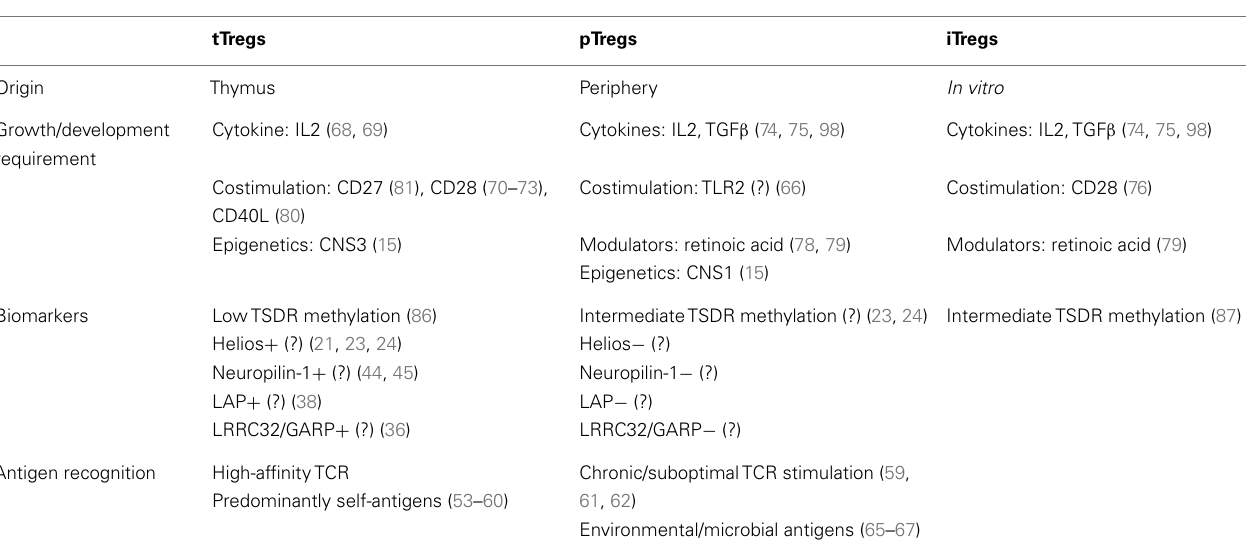
Table 1 | Distinguishing features ofTreg